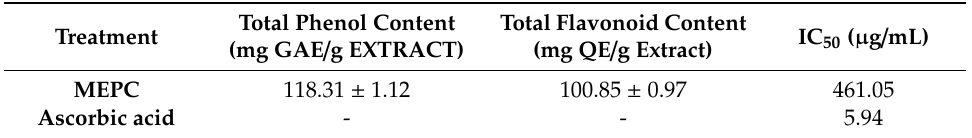
Table 3. Antioxidant activity by total phenol content, total flavonoid content of methanol extract of P. calocarpa leaves with IC 50 value.